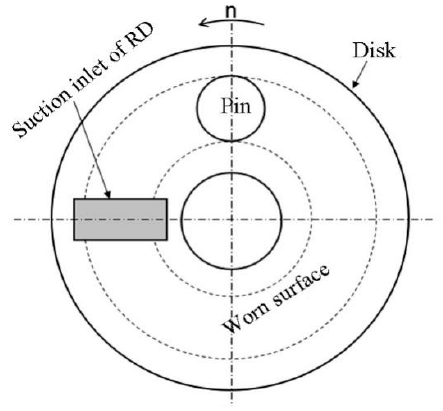
Figure 3 Suction inlet location of the removal device (RD). Figure 3. Suction inlet location of the removal device